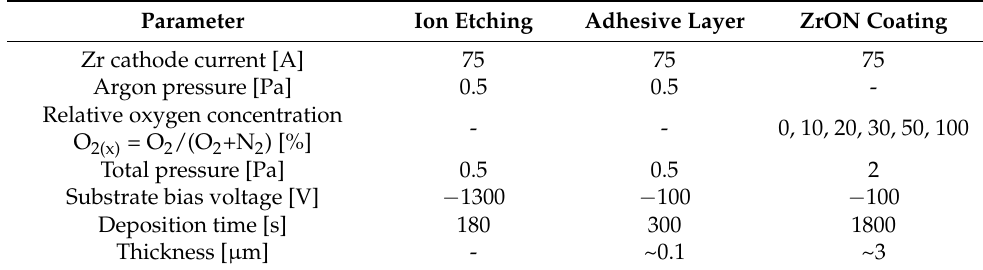
Table 2. Parameters for ZrON coatings